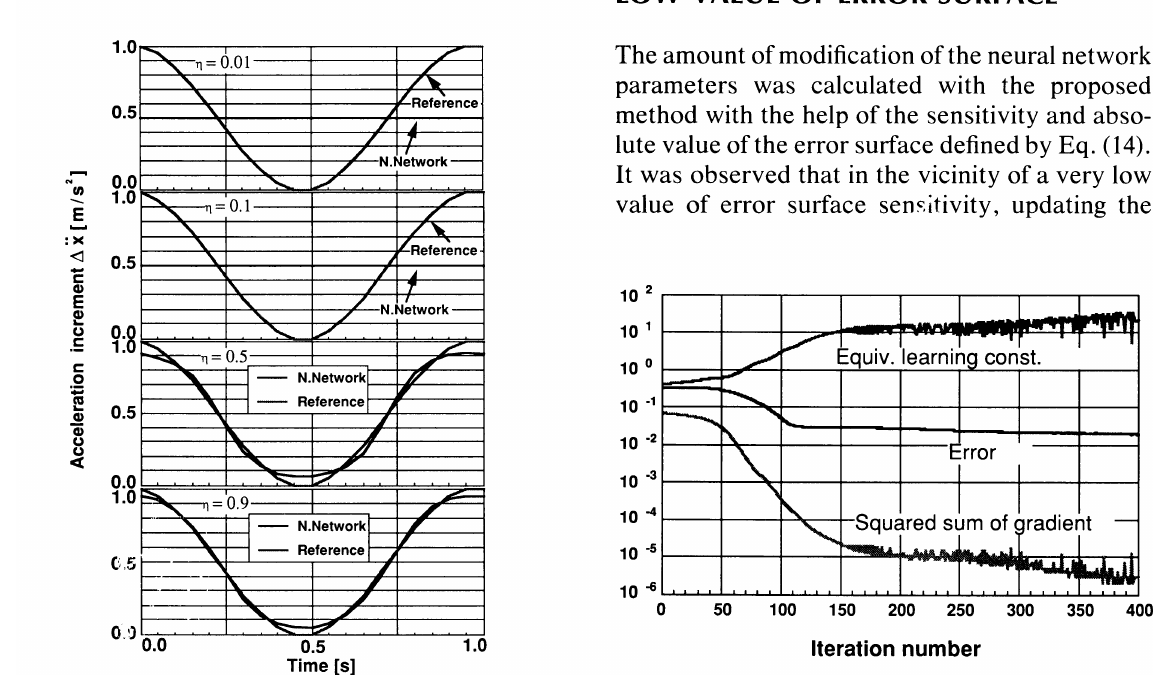
FIGURE 7 Results of dynamic system identification after 100 iterations by stiffest gradient method.